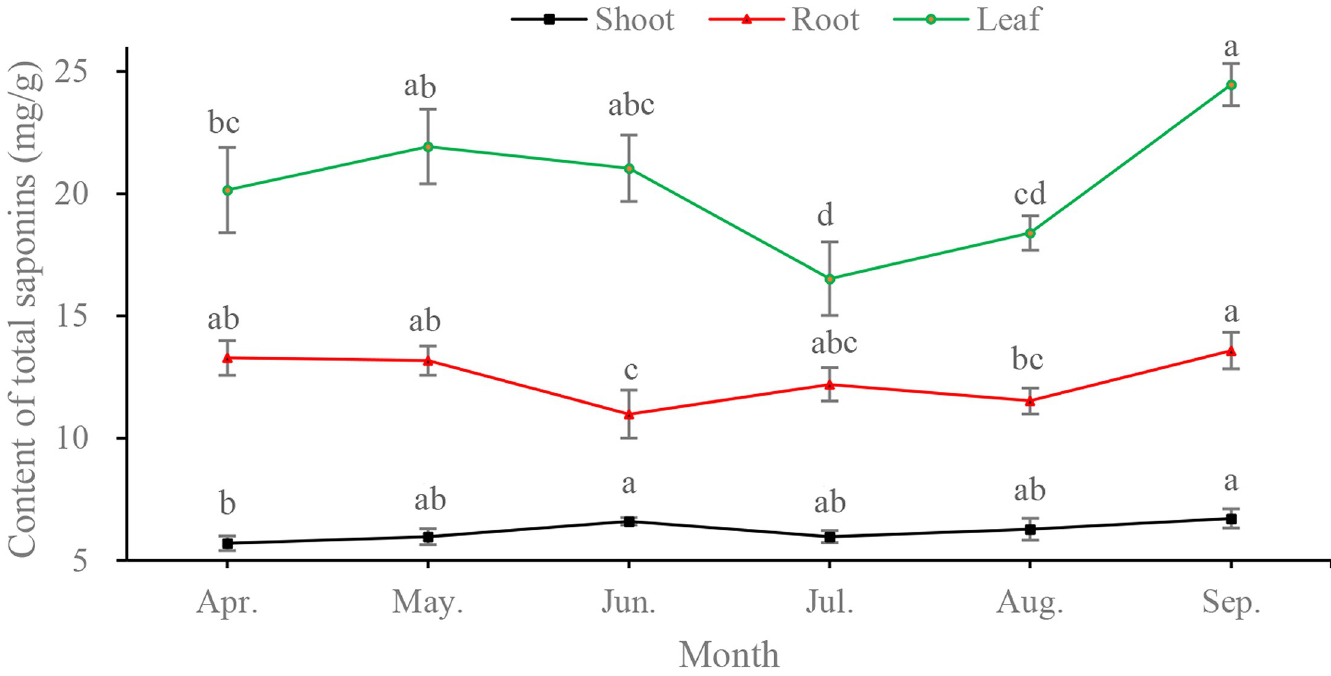
Fig 3. Dynamic patterns of saponins content in vegetative organs of C . paliurus at different months. Letters indicate statistical results at each month in shoot, root and leaf. The same letters indicate no significance according to Bonferroni test (P < 0.05).